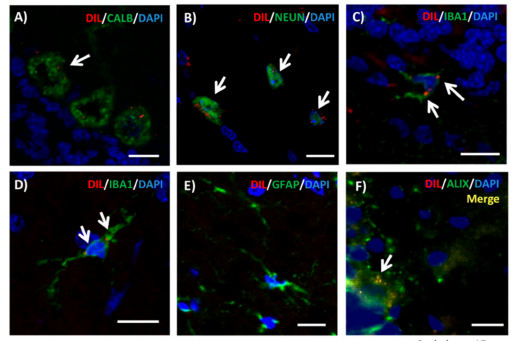
Figure 5. Intravenously injected dil-labeled extracellular vesicles (red) reach the cerebellum after 72 h. Co-localization was found with ( A ) Purkinje neurons, ( B ) neurons located in white matter, ( C ) microglial cells in the molecular layer, and ( D ) microglial cells in white matter. ( E ) No co-localization was observed with astrocytes in white matter. ( F ) We confirmed that red fluorescence signal co-localizes with Alix, a marker of extracellular vesicles. Scale bar = 15 µ m.